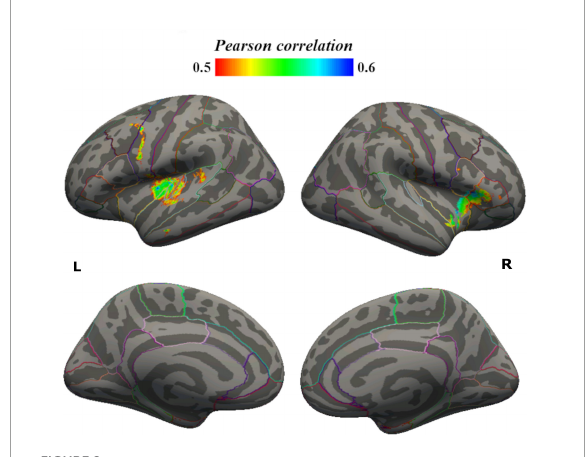
FIGURE2 Total BPRS—LGI correlation, between-group